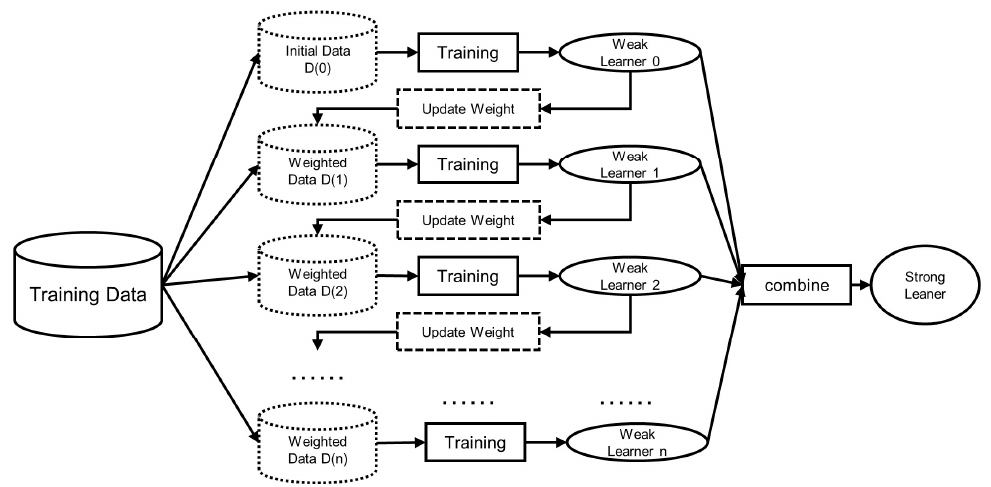
Figure 4. Model training process of the boosting algorithm in ensemble learning.